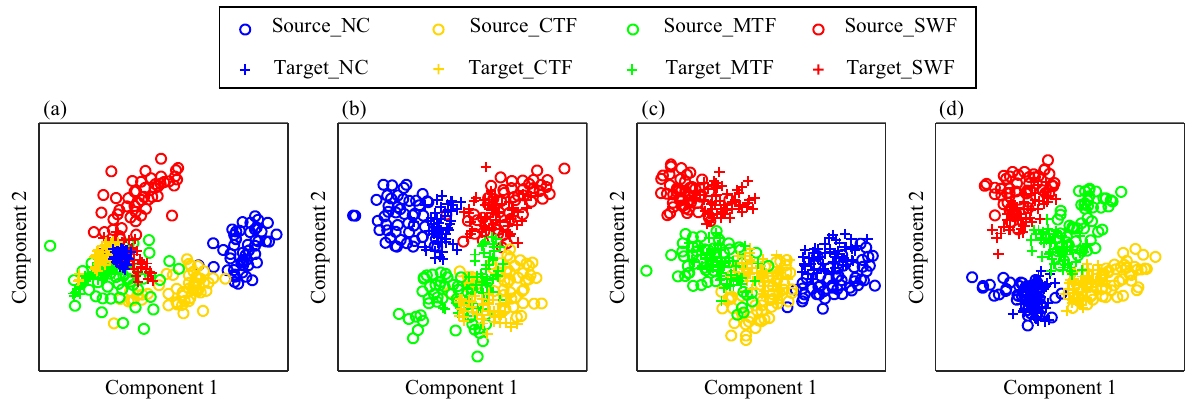
Fig. 10 The visualization of the learned features on the dataset C 1 (source domain) and the dataset A1 (target domain): ( a ) CNN, ( b ) DANN, and ( c ) DTLN-T, ( d )